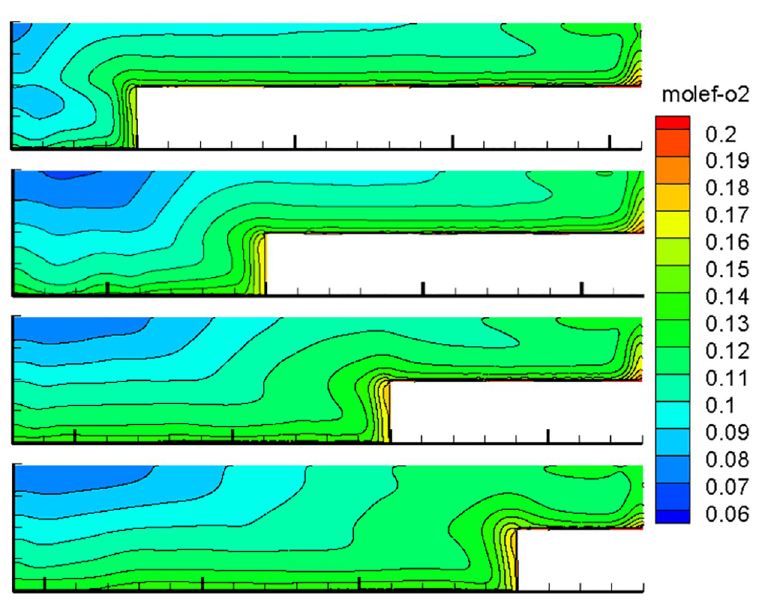
Fig 10. Flow field distribution of the oxygen volume fraction in the goaf at 10% air